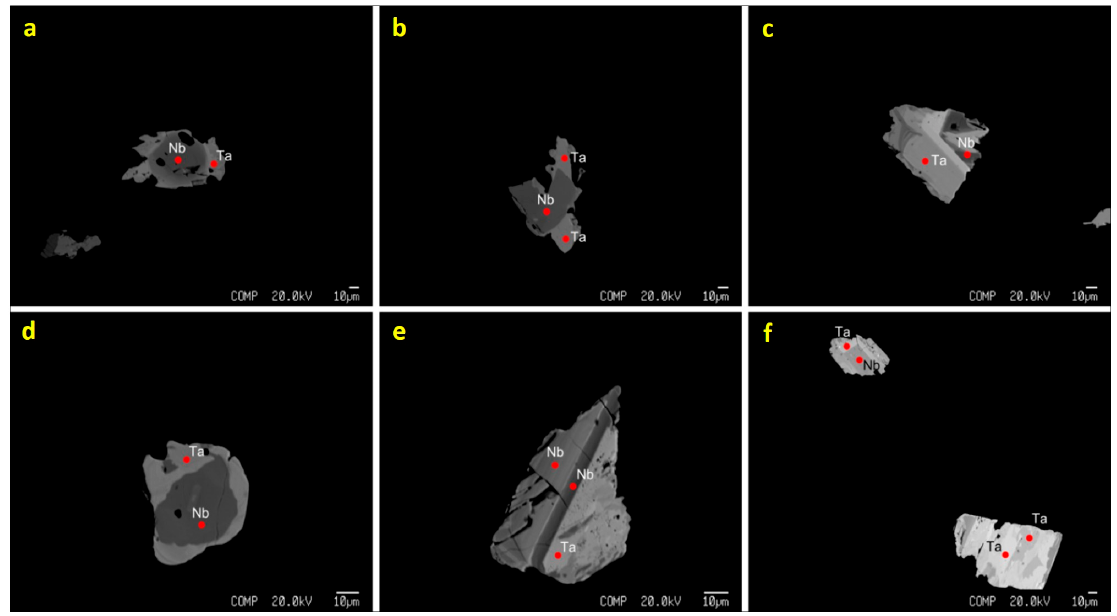
Figure 11. Plot of molar ratio of cations Fe + Mn and Nb + Ta. The 2:1 ratio expected based on the stochiometry of columbite-tantalite (Fe,Mn)(Nb,Ta) 2 O 6 is included.